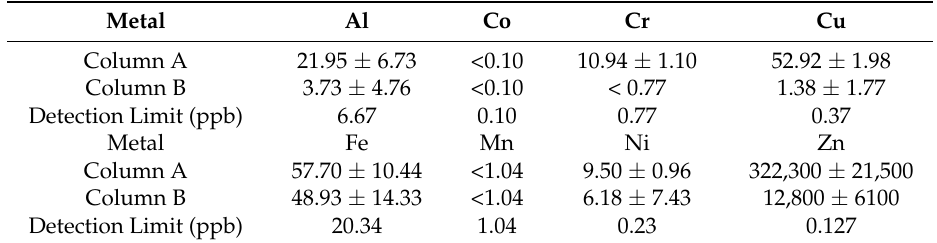
Table 2. The concentration of metal impurities in the eluate following the extraction and purification 66 Ga 3+ ions as determined by ICP-MS. Values are expressed as ppb ± standard of 66 Ga 3+ ions as determined by ICP-MS. Values are expressed as ppb ± standard deviation.